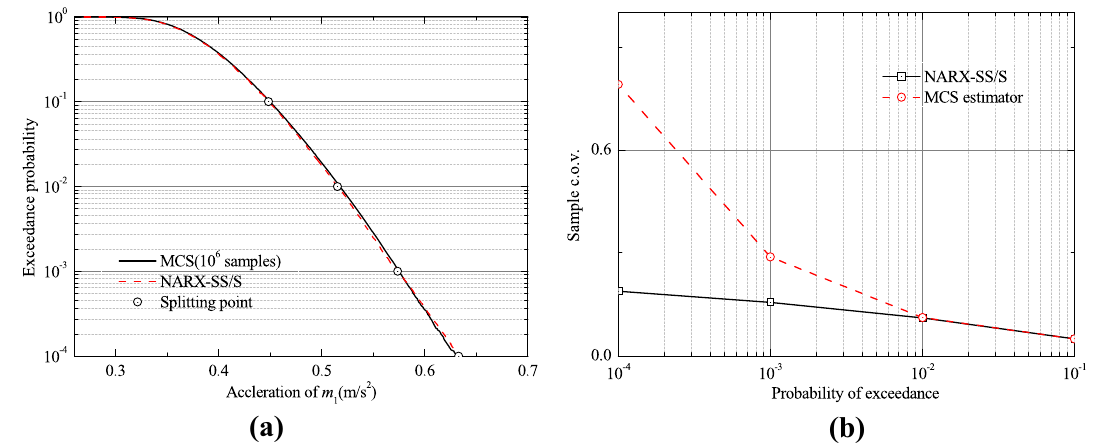
Fig. 6 Comparison of MCS and NARX-SS/S methods: a exceedance probability of train body and b comparison of c.o.v. for different estimators